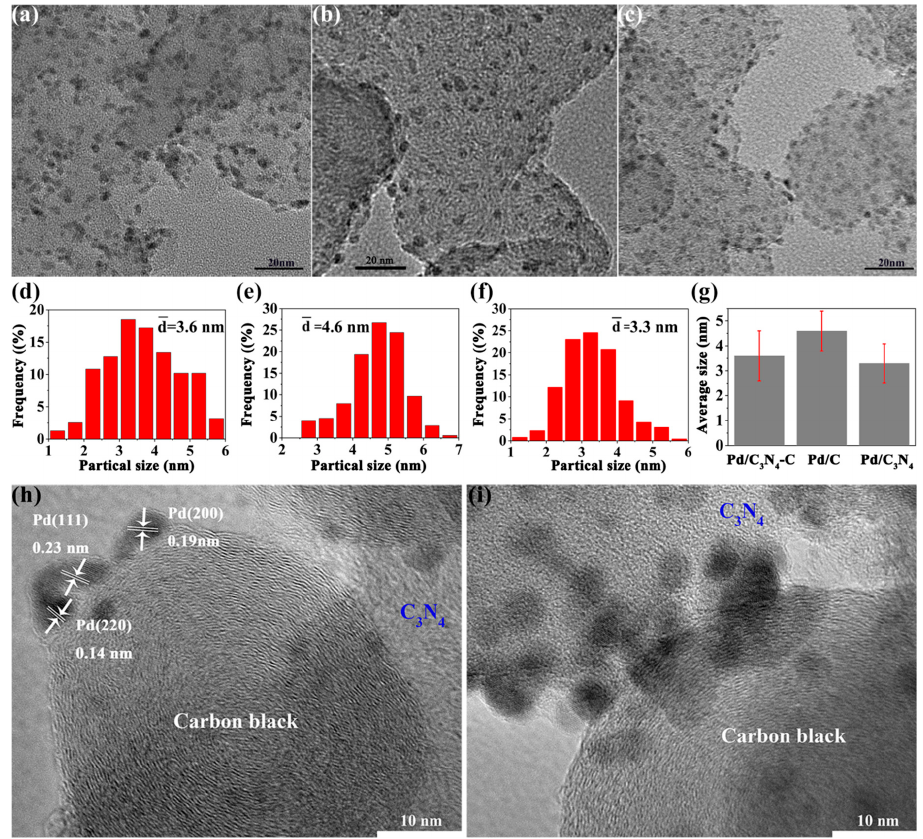
Figure 2. TEM images and corresponding histograms of Pd NPs size distribution. ( a , d ) Pd/C 3 N 4 , ( b , e ) Pd/C, and ( c , f ) Pd/C 3 N 4 -C. ( g ) The standard deviation of the Pd NPs sizes. ( h , i ) High-resolution TEM images of Pd/C 3 N 4 -C.